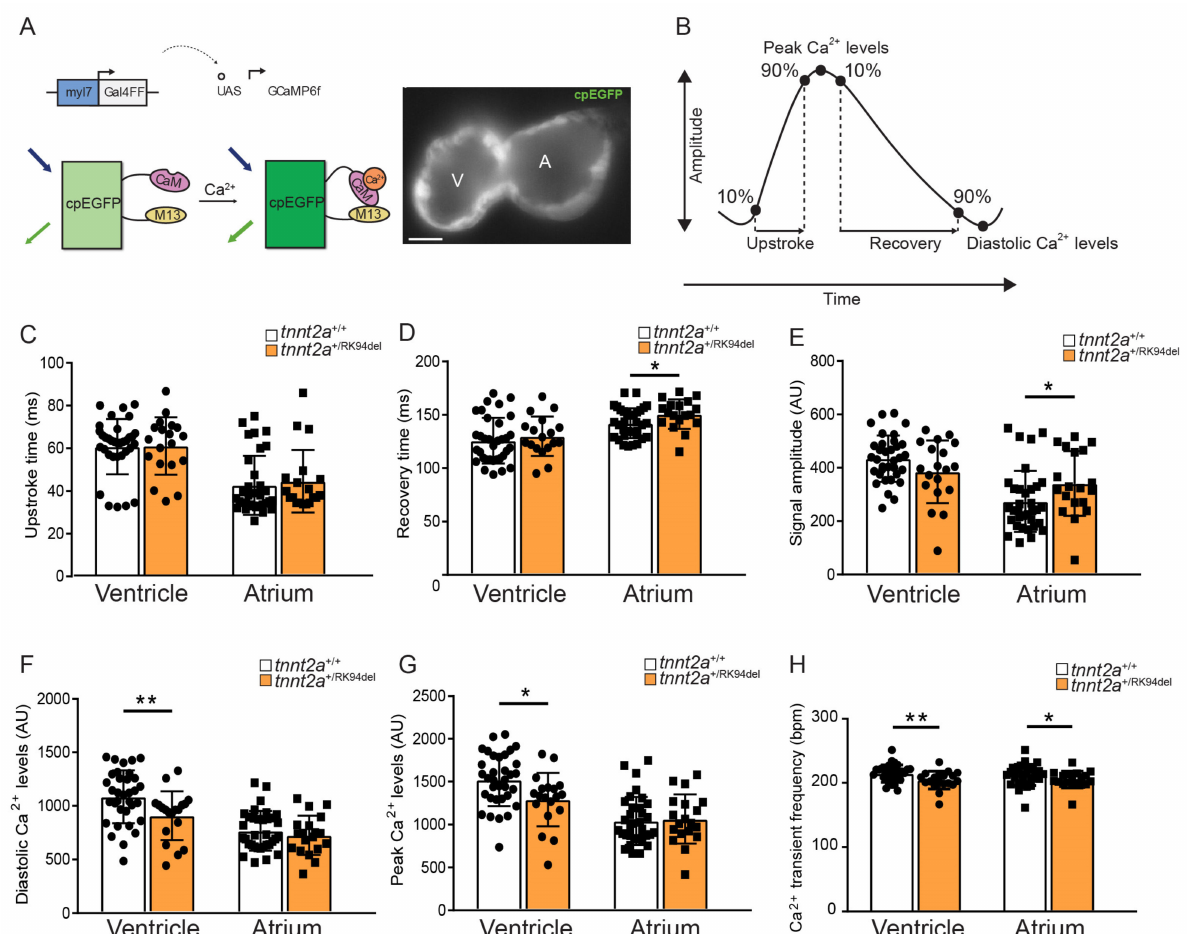
Figure 5. tnnt2a +/RK94del mutation causes intracellular calcium dysregulation in zebrafish embryos. ( A ) DNA construct and sensor dynamics of GCaMP6f (left panel). GCaMP6f was placed under the control of the myl7 promoter to restrict its expression to the heart, where the Gal4FF-UAS system amplifies its expression. GCaMP6f consists of a circularly permutated enhanced green fluorescence protein (cpEGFP) fused to calmodulin (CaM) and the M13 peptide. Upon the increase of intracellular calcium (Ca 2+ ), CaM binds to M13, causing increased brightness of cpEGFP. This is visualized using a high-speed epifluorescence microscope, where movies of 5 dpf non-contracting GCaMP6f embryonic hearts were recorded (left panel). ( B ) Schematic representation of Ca 2+ transient parameters examined from the recorded GCaMP6f signals. ( C – G ) Bar graphs of the different Ca 2+ transient parameters for tnnt2a +/+ and tnnt2a +/RK94del , including upstroke time, recovery time, signal amplitude, diastolic Ca 2+ levels, and peak Ca 2+ levels. ( H ) Frequency of Ca 2+ transients tnnt2a +/+ and tnnt2a +/RK94del . AU: arbitrary unit. Statistics: mean ± SEM, * p ≤ 0.05, ** p ≤ 0.01, tnnt2a +/+ n = 34, tnnt2a +/RK94del n = 19, unpaired Students t-test. A: atrium, V: